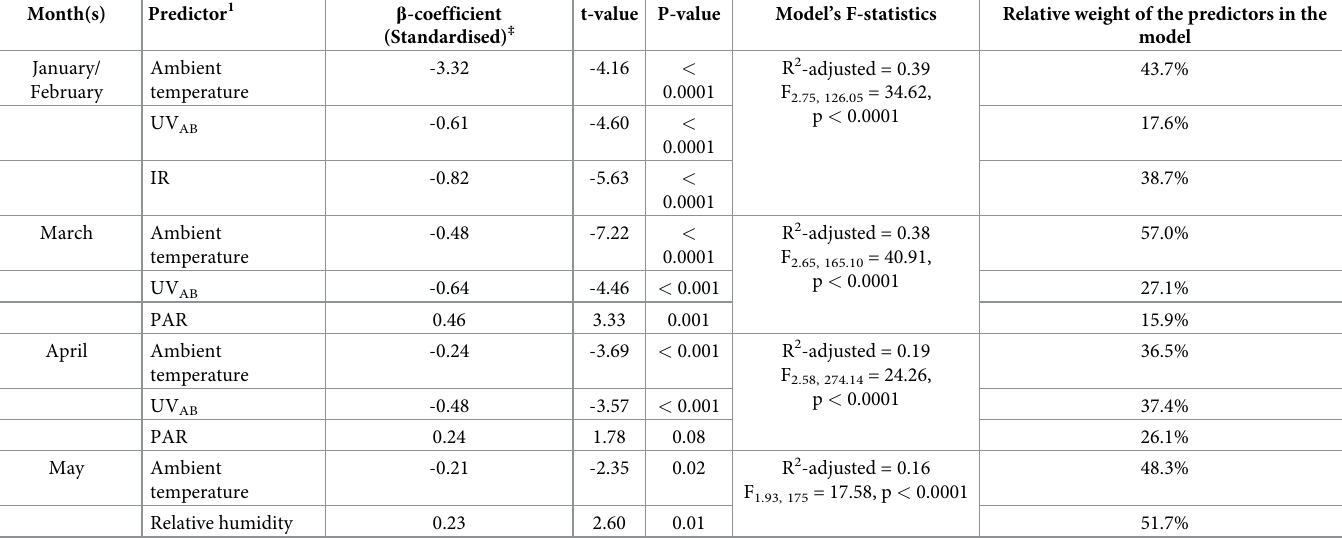
Table 8. Multiple ridge regression analyses (ridge parameter, k = 0.02) on the number of hens in the ‘sun’ across the day in WA for different observation months. Only variables that significantly contributed to the most parsimonious model are presented.